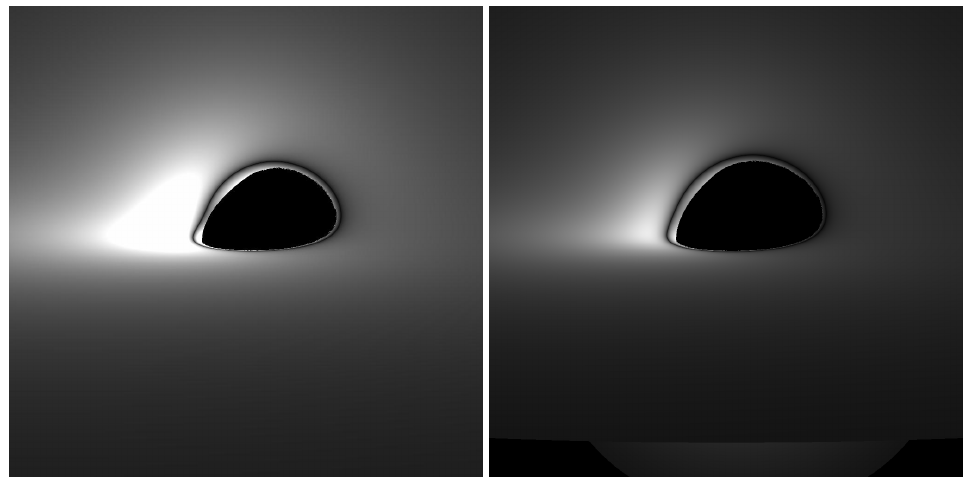
Figure 4. The explanation is the same as in Figure 3. The left panel shows the simulation for pc-GR and n = 3 (the same as the right panel in Figure 3), while the right panel is a simulation for n = 4. As noted, the position of the dark and bright rings are shifted slightly to larger radial distances. The figures were obtained using the open accessible 2014 version of the GYOTO routines [48]. For n = 4, the modified C++ rountines can be retrieved in